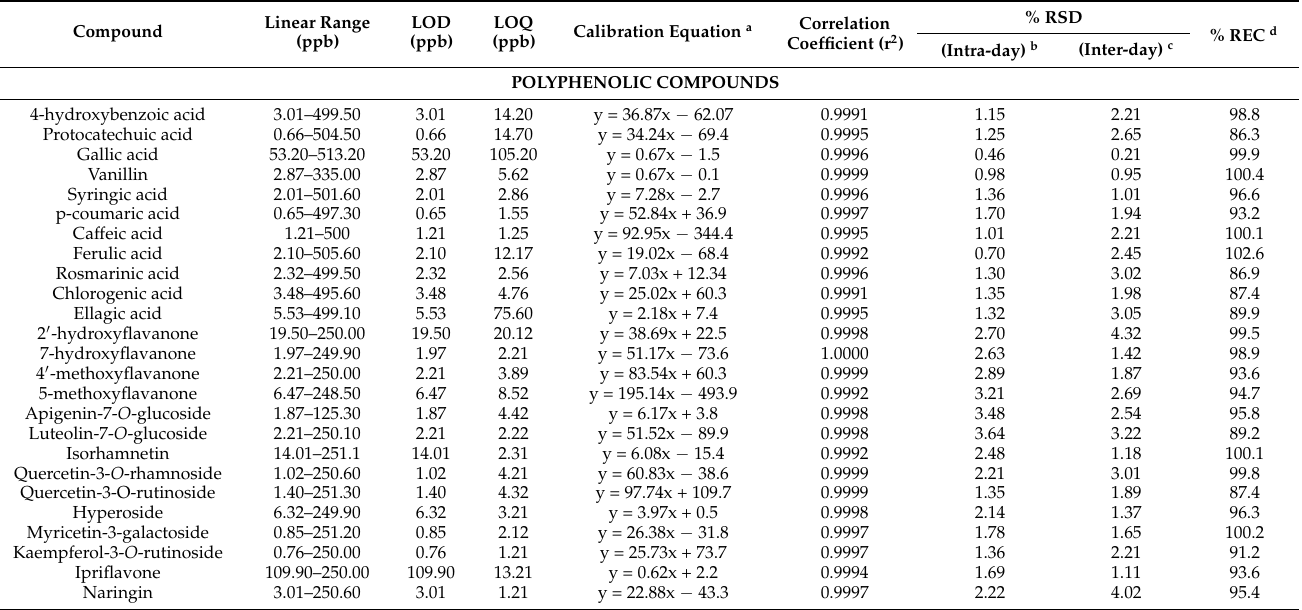
a Chromatographic peak area (y) as a function of ppb concentration (x); b values are means of intra- day assays ( n = 6); and c values are means of inter-day assays ( n = 6); d ( n = 3). The standard curves generated from the standards were plotted with a linear regres- sion equation of response peak areas as a function of various concentrations of com- pounds ranging from 0 to 500 ppb (Figure 1).